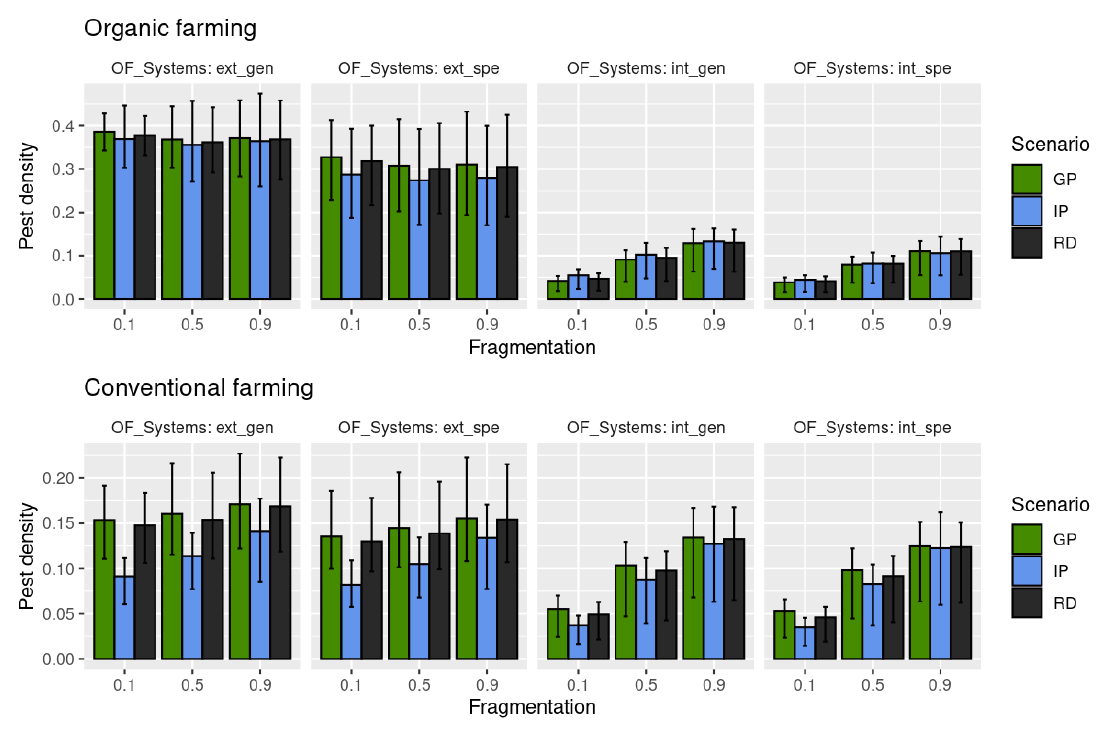
Figure S2 . Effects of organic farming expansion scenario, organic farming type and landscape structure on the density of pests in organic and conventional fields. “ext” and “int”: low vs high pest management intensity, respectively. “spe” vs “gen”: specific vs gene ralist pest management practices, respectively (see Table. 3). Error bars represent standard deviations over